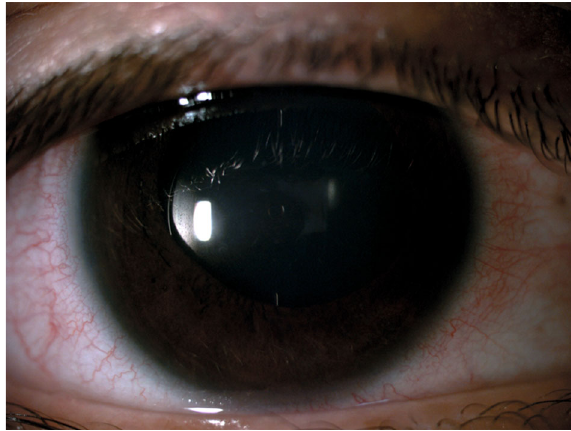
Figure 6: Fixed dilated asymmetric pupil in the right eye, consistent with